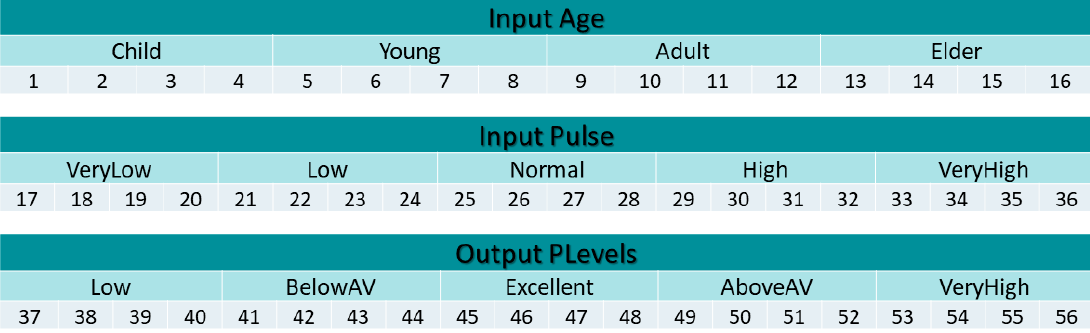
Figure 10. FIS representation in BSA with trapezoidal MFs.